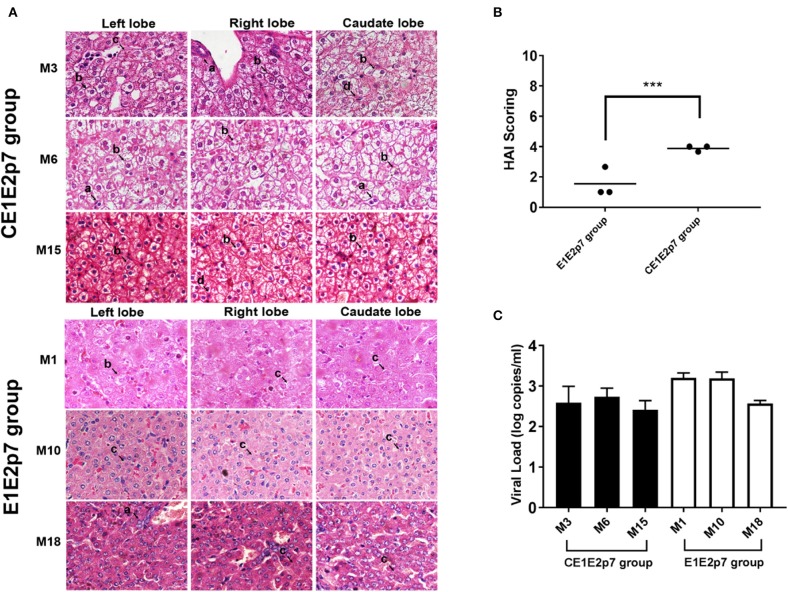
Difference of necroinflammatory grade in histopathological changes of liver tissues between marmosets infected by HCV chimeras with or without HCV core protein. (A) H&E staining was conducted on the liver tissues collected by left, right, and caudate lobes of each liver from marmosets. The original magnification was × 800. (a) Lymphocytic infiltrates, (b) ballooning degeneration (edema), (c) ground glass liver cells, and (d) eosinophilic cells. (B) Necroinflammatory grades in histopathological changes of liver tissues were scored by the modified HAI system, in which inflammation grades were on a scale of 0 to 18. ***P < 0.001. (C) The viral loads in the liver tissues infected with HCV-CE1E2p7/GBV-B or HCV-E1E2p7/GBV-B for the time points used for cDNA library construction and sequencing.